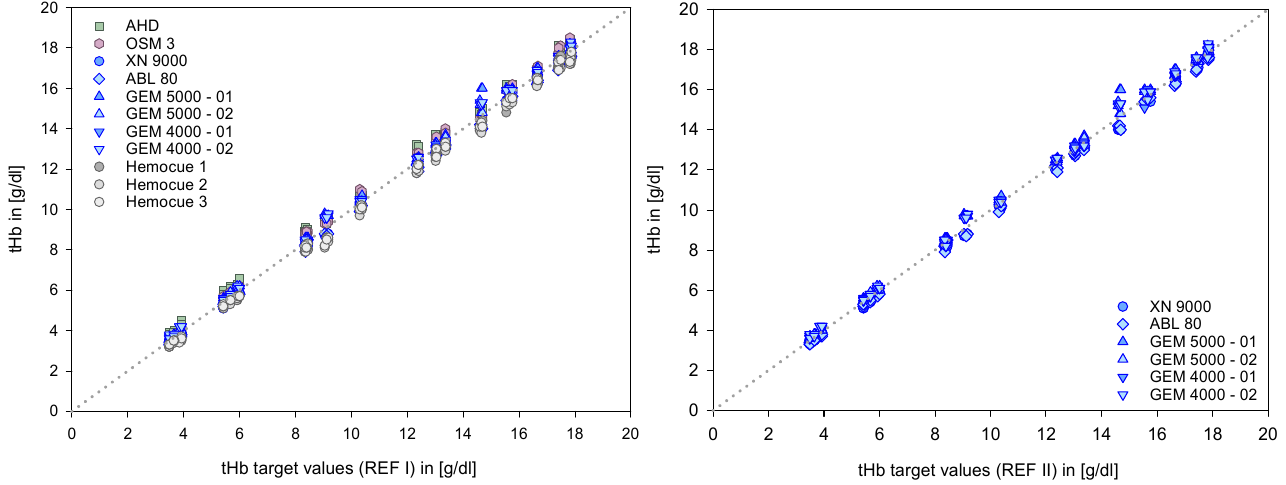
Figure 2. Data points of each device are plotted against their target values (mean of all). The left side shows the data from all devices in the test with REF I, the right side the data from the clinically relevant devices with REF II.